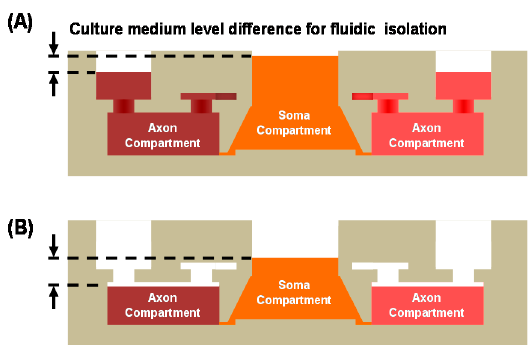
Figure 6. Cross-sections of the high-throughput compartmentalized neuron culture platform showing the fluidic isolation scheme during: ( A ) the culture medium replenishment process; and ( B ) localized biomolecular treatment.